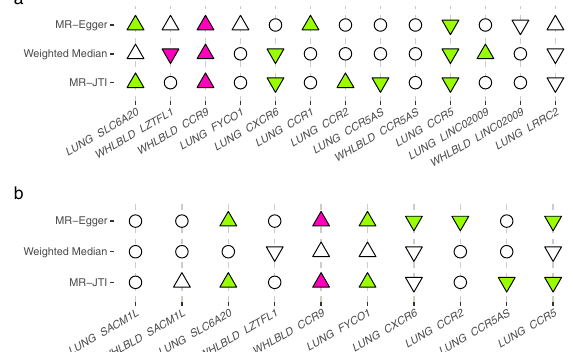
Fig. 4 Mendelian randomization identi fi es candidate causal genes. MR-JTI was performed for the JTI signi fi cant ( P FDR < 0.05) genes for COVID-19 hospitalization ( a ) and severity ( b ) using the GWAS summary statistics from COVID-19 HGI round 6. Here, we provide visualization for the results derived from lung (LUNG) or whole blood (WHLBLD). Mendelian randomization results from MR- Egger, Weighed Median estimate, and MR-JTI are shown. The plot illustrates convergence of causal inference and concordance of direction of effect from the various Mendelian randomization approaches. For example, CCR9 in whole blood showed signi fi cant causal effect and concordant direction from all three Mendelian randomization methods (panel a ). Hollow circle, hollow triangle, and solid triangle denote non-signi fi cant, only nominally signi fi cant, and signi fi cant (i.e., after Bonferroni correction) results. Up (positive) and down (negative) triangles indicate the direction of the estimated effect